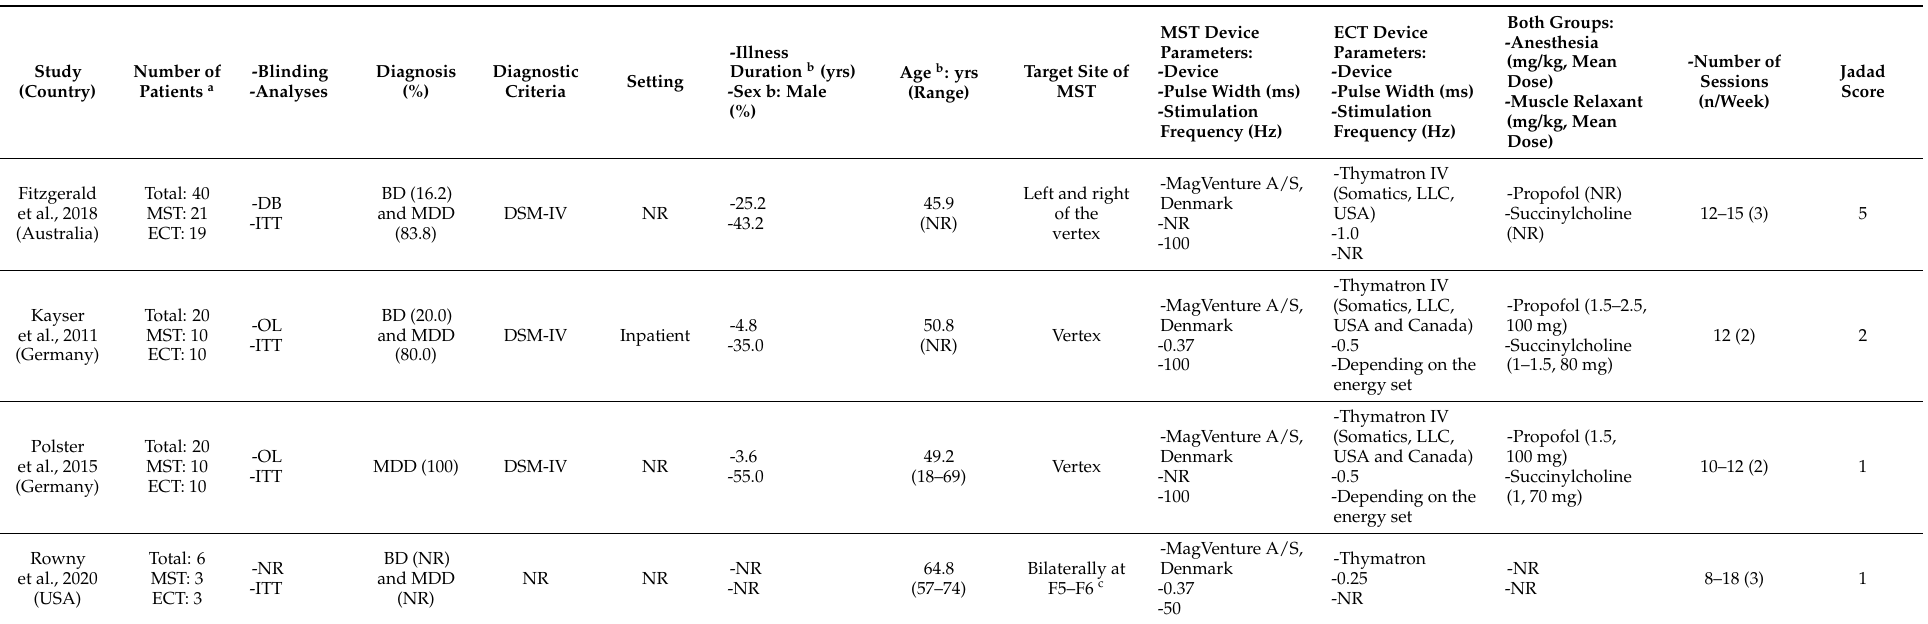
Table 1. Participant characteristics and MST/ECT parameters for each included